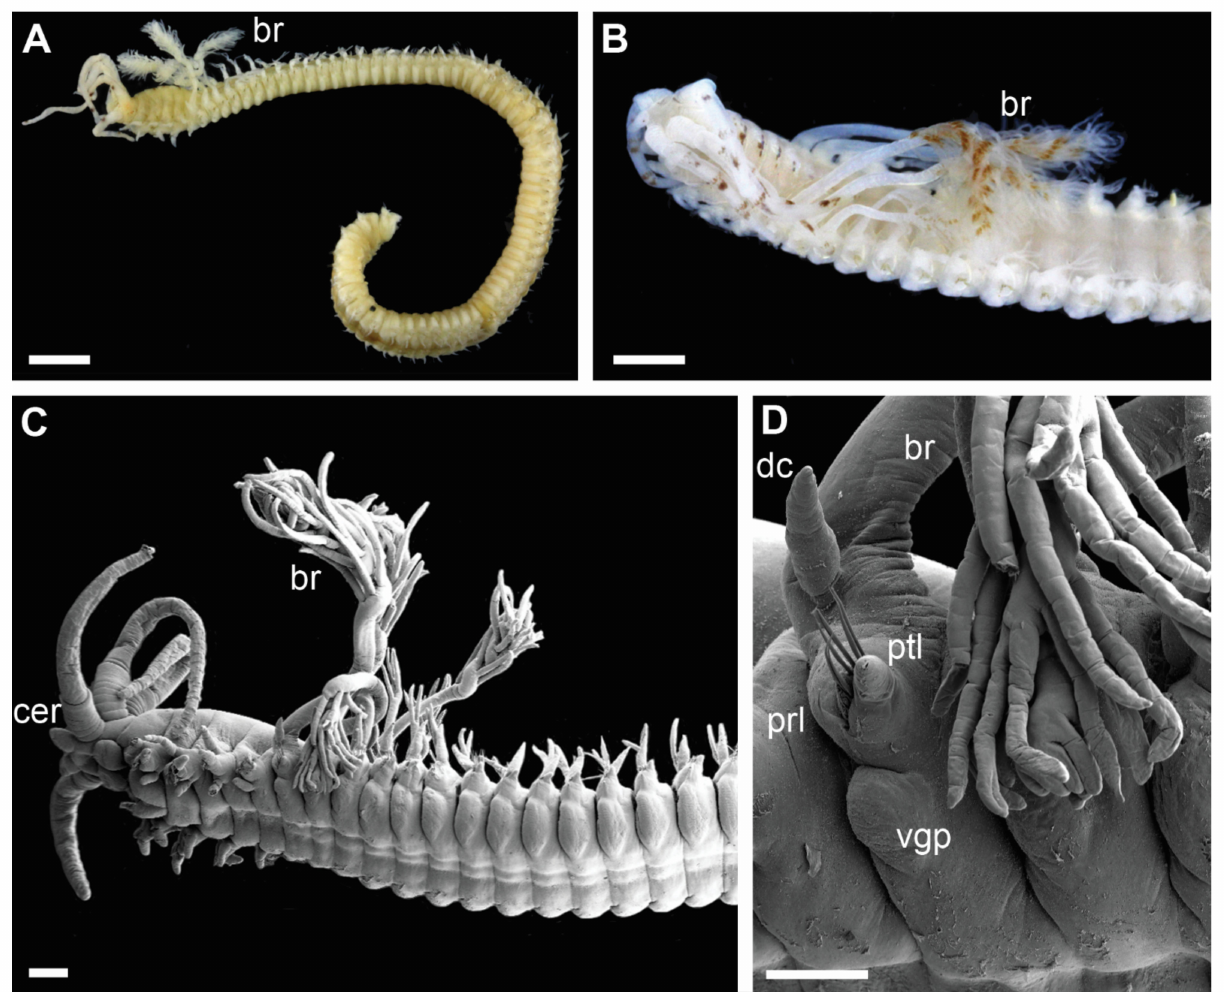
Figure 4. Morphology of Diopatra Complex A species representing Clade 3. ( A , B )—light microscopy photographs; ( C , D )—scanning electron microscopy images. ( A , B ): Anterior fragment of ZMBN126813 showing first 2–3 pairs of branchiae with long stems; ( C ) anterior fragment of ZMBN145682, lat- eral view; ( D ): The same as ( C ), parapodium from chaetiger 5, lateral view. br—branchia; cer— ceratophore; dc—dorsal cirrus; prl—prechaetal lobe; ptl—postchaetal lobe; vgp—ventral glandular pad. Scale bars: ( A , B )—1 mm; ( C )—200 µ m; ( D )—100 µ